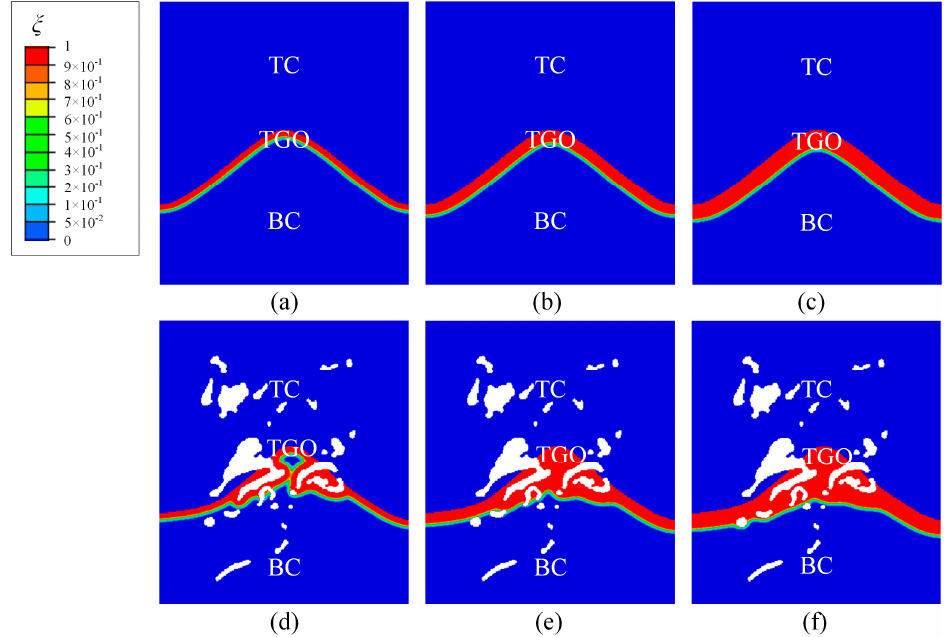
Figure 6. The contour plots of TGO thickness after ( a ) 50, ( b ) 150, and ( c ) 300 h oxidation for the idealized TBC, and TGO layer in TBC with actual microstructures after ( d ) 50, ( e ) 150, and ( f ) 300 h oxidation.